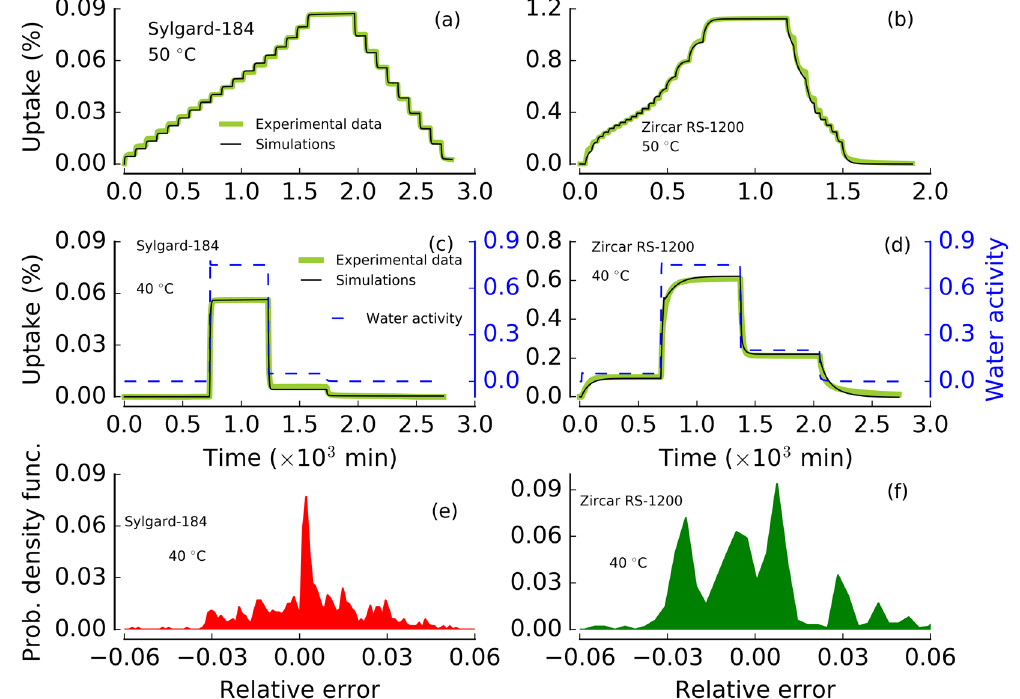
Figure 7. Model performance (for sorption region) and prediction (for outgassing region) in Sygrad-184 (panel a) and Zircar RS-1200 (panel b) at 50 °C. Optimized parameters from sorption region are used to purely predict the outgassing region. Water activity range is 0–0.9 in both experiment with a water activity jump step of 0.05 during sorption and a step of 0.1 during desorption. Similar to sorption, outgassing behavior is distinctly different in Sylgard-184 and Zircar RS-1200 and well captured by our diffusion triple-mode sorption model. Model prediction against step experiments in Sylgard-184 (panel c), and Zircar RS-1200 (panel d) at 40 °C. Water activity is shown on right y-axis in panel c and panel d. Probability density function vs relative error (obtained from relative error between experimental data and model simulations) is shown for Sylgard-184 (in panel e, using data from panel c) and Zircar RS-1200 (in panel f, using data from panel d) at 40